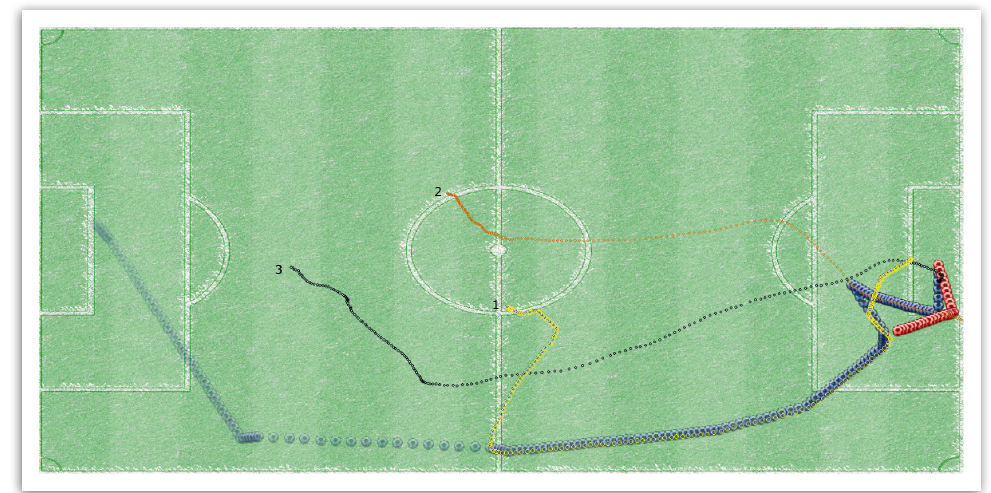
Figure 10. Annotated and former unknown detected fast attack over the right flank by the blue team. Remarkable is the interaction between the three participating offensive players, here displayed by their visualized trajectories. Each trajectory is labeled by a number and colored separately. The color of the ball represents which team was at which moment in possession of the